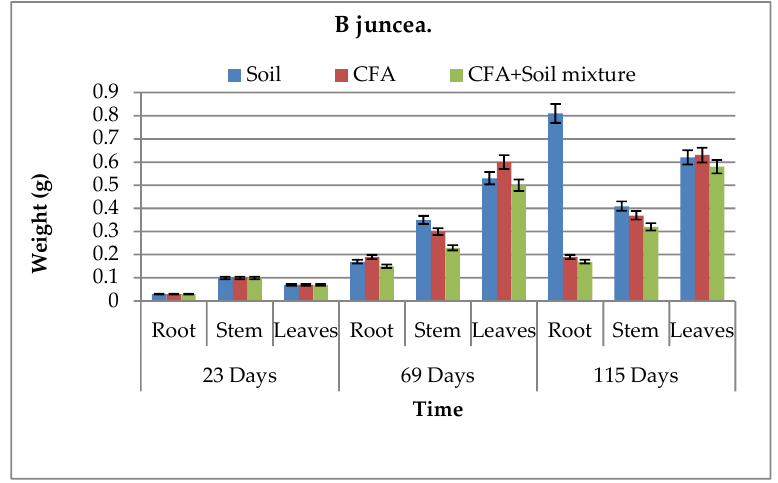
Figure 6. Growth performance of B. juncea in all growth media. CFA: Coal-fly-ash.